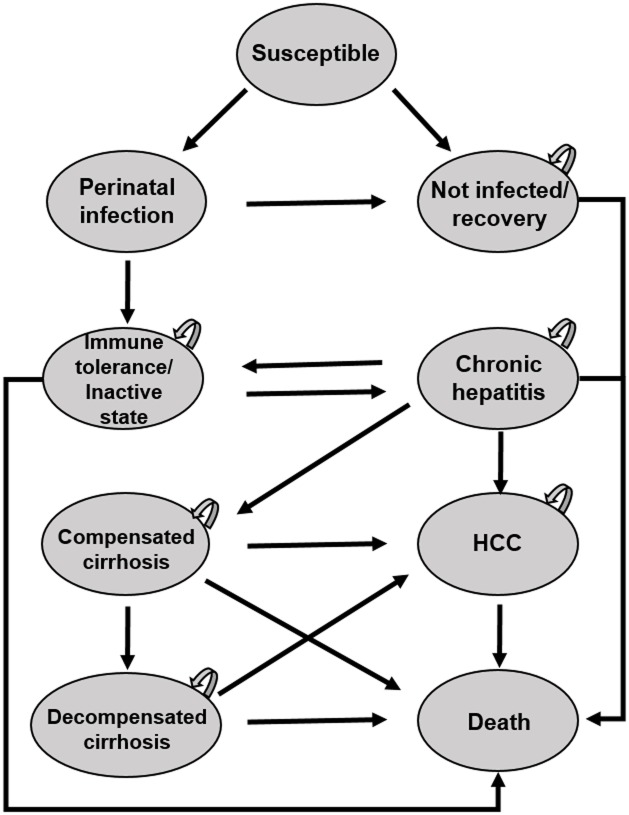
Markov model of natural history of HBV infectiona.a. HCC, Hepatocellular carcinoma